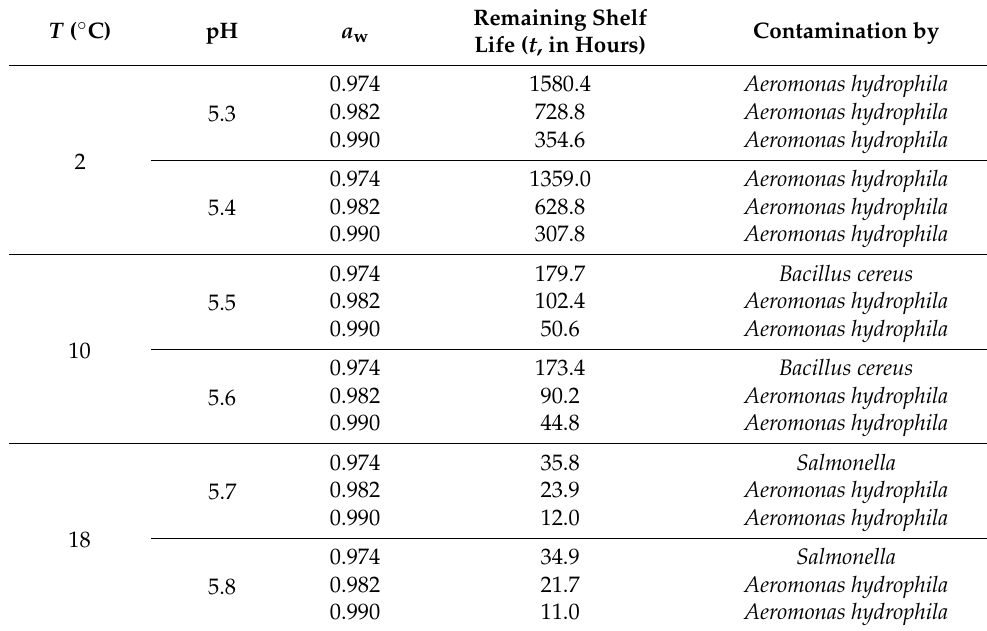
Table 7. Sampling of results of DSS—Remaining shelf life of